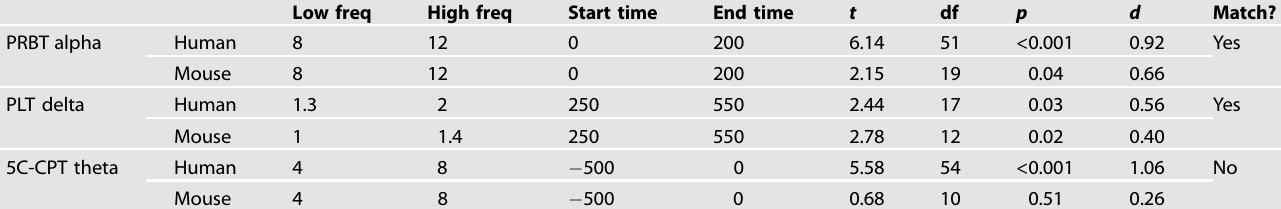
Table 3. Summary of simple